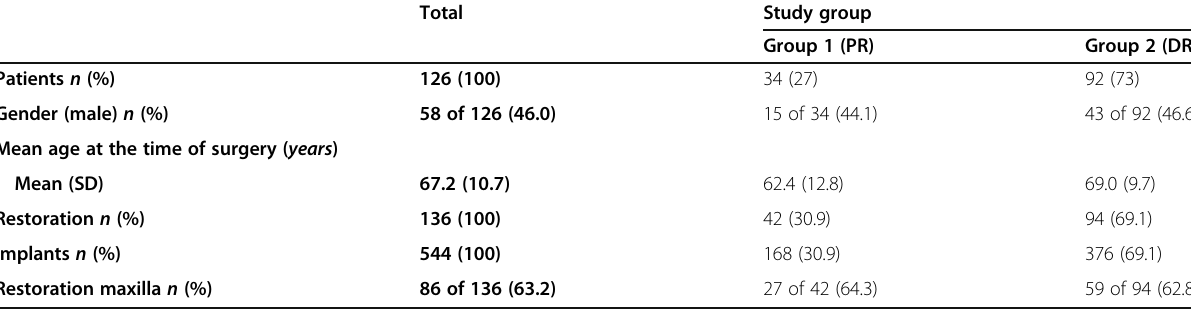
Table 1 Baseline characteristics of the study groups at the time of restoration